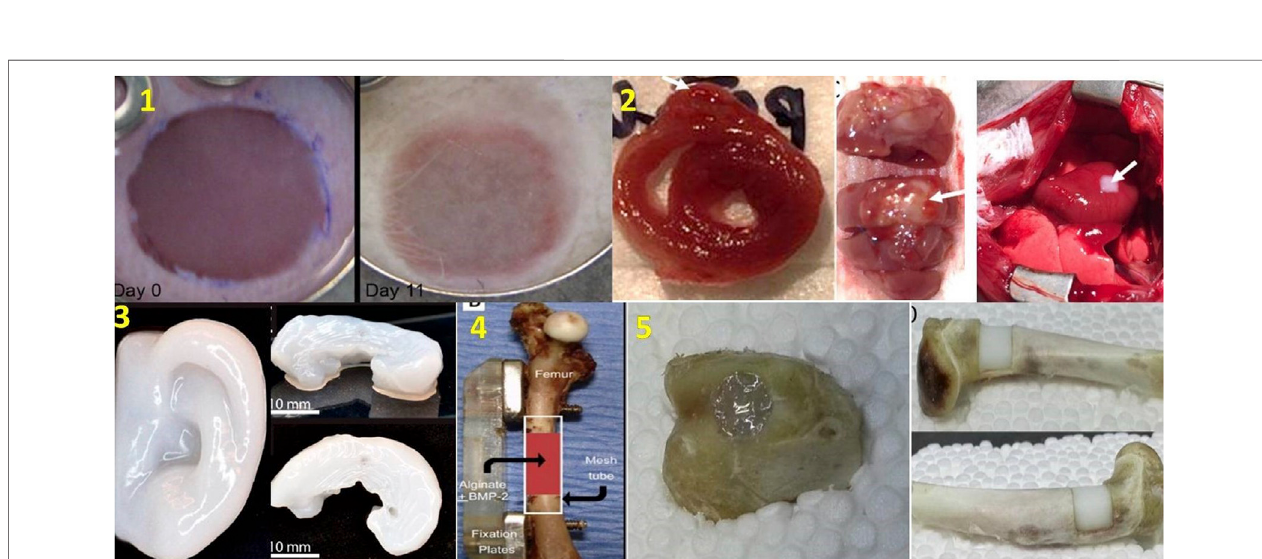
FIGURE10| Differentbioprintedorgans.1)Skinconstructincludes20layersofkeratinocytesand fi broblastsimplantedintothewoundDay0(atleft)andDay11(at right) (He et al., 2018), 2) Cross-section of 3D bioprinted cardiac patches (at left), anterior aspect (at middle), In vivo transplantation of cardiac patches (at right) (Ong et al.,2017)3) 3Dbioprintedhumanear(atleft) and sheepmeniscus (atright)(Moriet al.,2018),4)Treatmentoffemur defectusing polymeric hydrogeland growthfactor (Mori et al., 2018)5) Fixing ofbone defects using in situ 3D bioprintingwith alginate hydrogel, transparentbeforephotopolymerization (at left), becomes milkywhite after photopolymerization (at right) (Li et al., 2017) (used from open access journals).